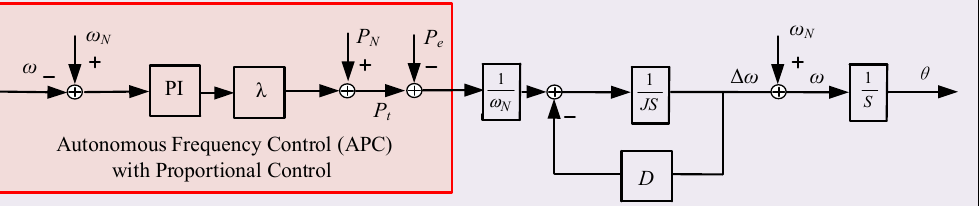
Figure 4. Autonomous frequency control with proportional control.